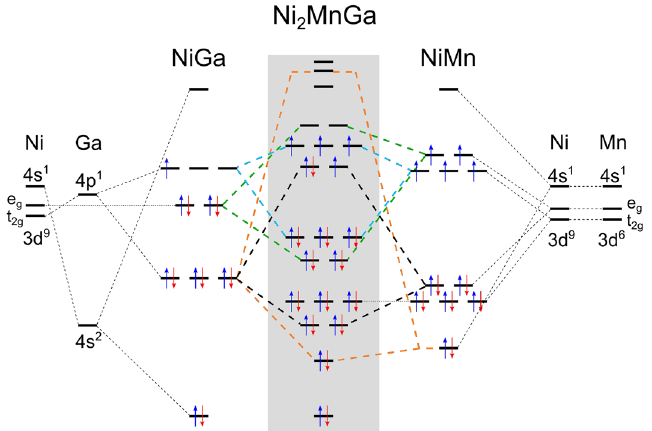
Figure 4. Orbital diagram for Ni 2 MnGa. The main interaction between Ni and Ga lattices after hybridization is given on the left side; the intermediate interaction between Ni and Mn atoms on the right side. Subsequently the Ni–Ga levels are refined because of the Ni–Mn interaction to form the diagram for the Ni 2 MnGa alloy. Both spin channels are depicted as degenerate for simplicity.